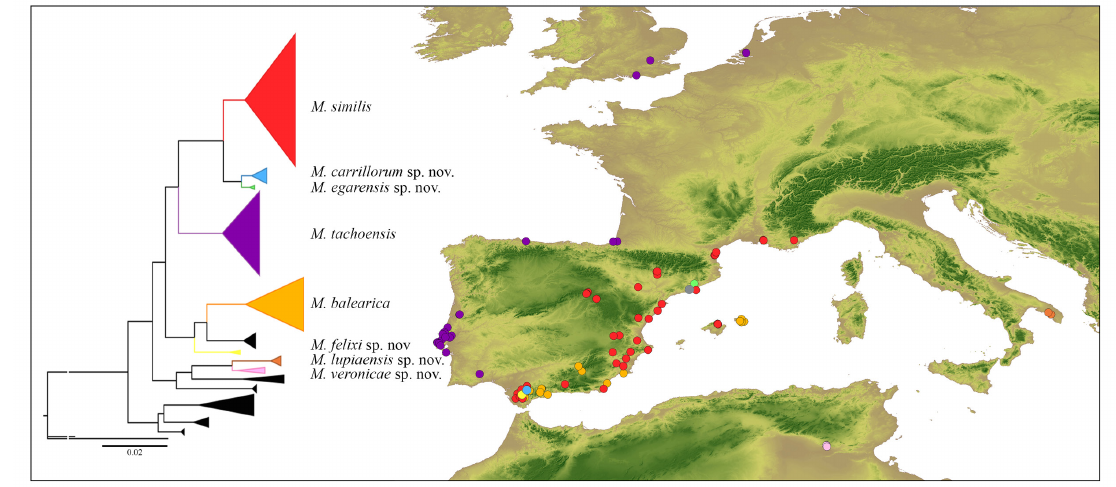
Fig. 1. Phylogenetic clustering and geographic location of the studied populations of Mercuria Boeters, 1971 throughout the western Palaearctic region. The tree topology on the left has been modified from Miller et al. (2022) to show the species clades (i.e., coloured clades) of the populations described here. One population (grey dot) represents the distribution of M. maceana (Paladilhe, 1869). Scale bar below topology: expected change per